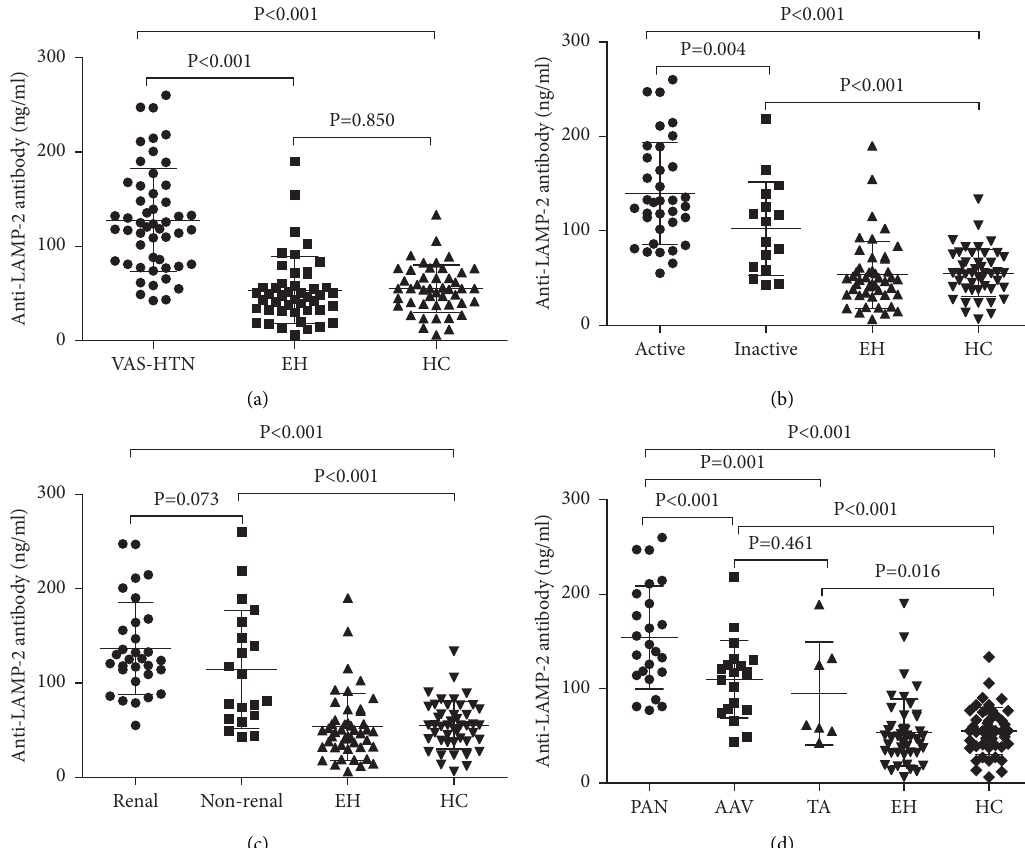
Figure 3: The levels of serum anti-LAMP-2 antibody in different groups. (a) In VAS-HTN patients and HC. (b) In VAS-HTN patients with the active stage and inactive stage. (c) In VAS-HTN patients with renal injury and non-renal injury. (d) In VAS-HTN